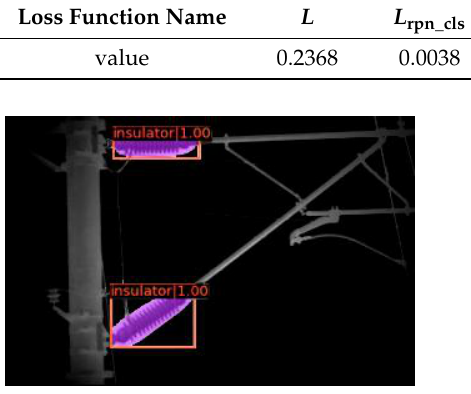
Figure 9. Loss function curve. Table 3. Loss function value.